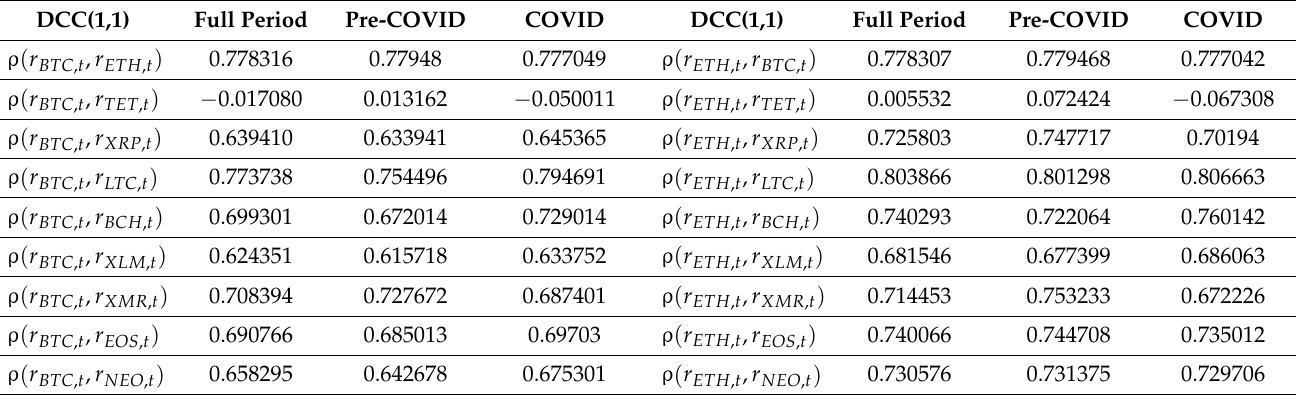
Table 14. Mean values of DCC(1,1) between the return indices of Bitcoin and Ethereum and the other cryptocurrencies for the three